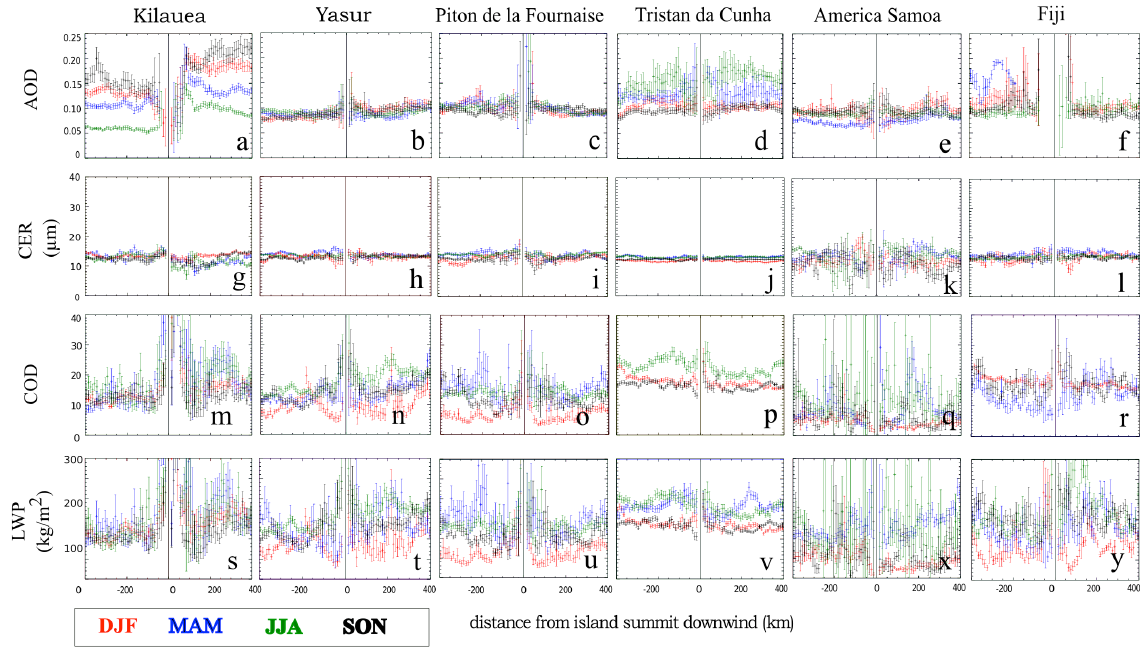
Fig. 4. Profiles of average aerosol and cloud properties upwind and downwind of the degassing volcano : K¯ılauea, Hawai’i; Yasur, Vanuatu Figure 4. Profiles of average aerosol and cloud properties from AATSR between 2002 and 2008, upwind and downwind of the degassing and Piton de la Fournaise, R´eunion and at ‘control’ islands: Tristan da Cunha, South Atlantic; American Samoa, West Pacific and Fiji, West volcano, presented as in Fig. 3, Pacific. Profile values are the average of arcs of π at equal distance upwind and downwind from the volcano vent for AATSR between 2 2002 and 2008. Separate profiles for different time of year are shown in different colours: December–February in red, March–May in blue, June–August in green and September–November in black. Error bars show one standard error for this average and are generally larger for low sample sizes. Positive values on the x-axis are downwind, negative upwind. The maximum diameter of the islands are indicated on the parameter plots as black dashed lines.